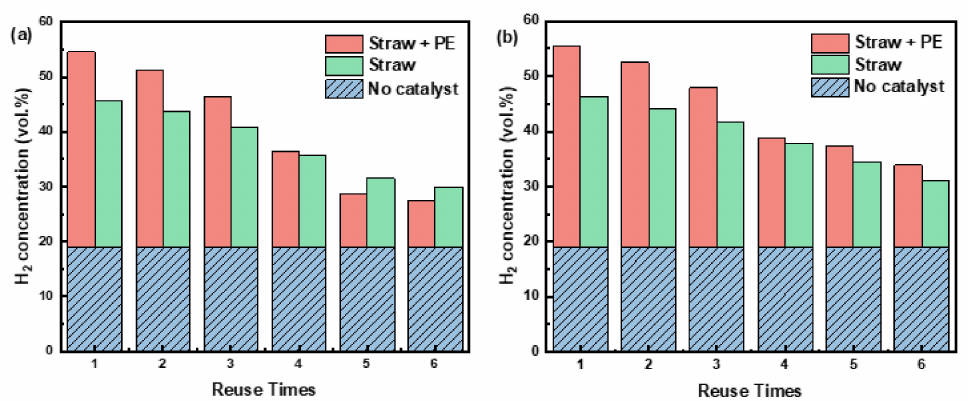
Figure 7. Effect of reuse times of catalysts on hydrogen production: ( a ) Ni/ACC(M); ( b )